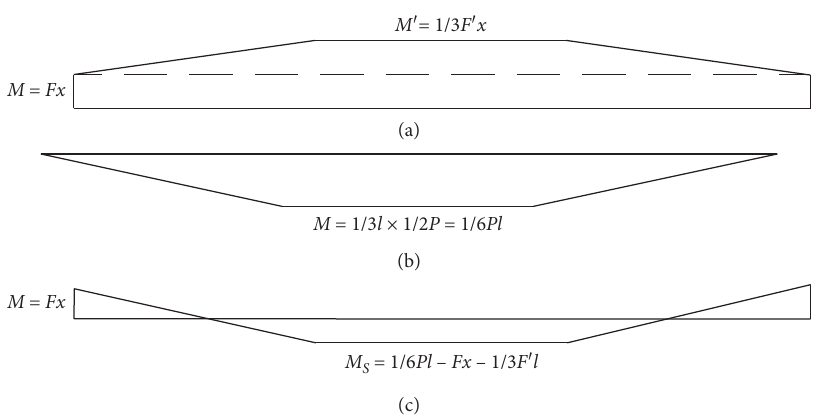
Figure 4: Bending moment of the glued laminated timber. (a) Bending moment during the prestressing stage. (b) Bending moment during the external loading stage. (c) Superposition of the bending moment during the loading